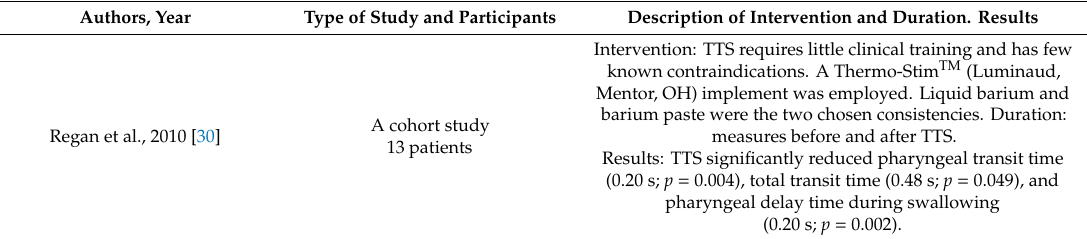
Table 2. Cont. Type of Study and Participants Description of Intervention and Duration. Results Intervention: TTS requires little clinical training and has few known contraindications. A Thermo-Stim TM (Luminaud, Mentor, OH) implement was employed. Liquid barium and barium paste were the two chosen consistencies. Duration: A cohort study measures before and after TTS. 13 patients Results: TTS significantly reduced pharyngeal transit time (0.20 s; p = 0.004), total transit time (0.48 s; p = 0.049), and pharyngeal delay time during swallowing